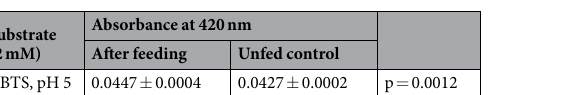
Table 1. Laccase activities in B. tabaci flies fed a sucrose diet. Two hundred B. tabaci adults were exposed to 200 μ L of a 10% sucrose solution for 24 h, and subsequently, 50 μ L of the recycled feeding liquid was analysed in a microplate reader at 28 °C for 5 min. Mean ± SEM, n =